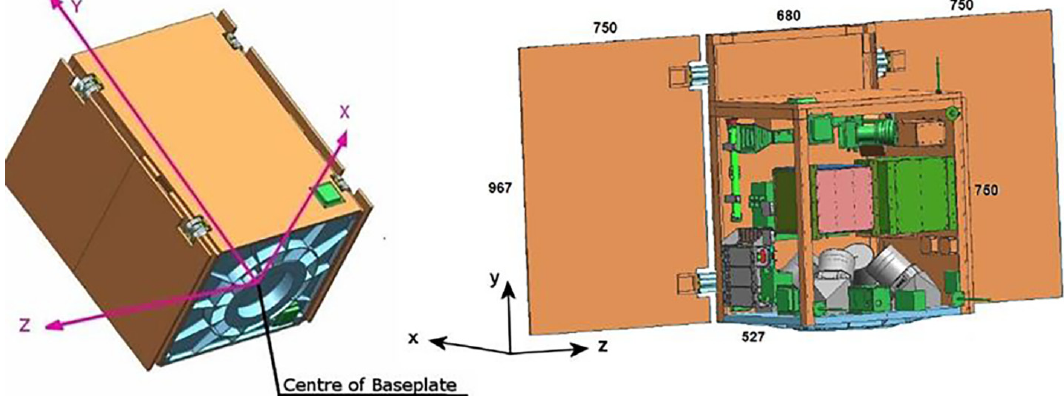
Fig. 1 External view of ESEO